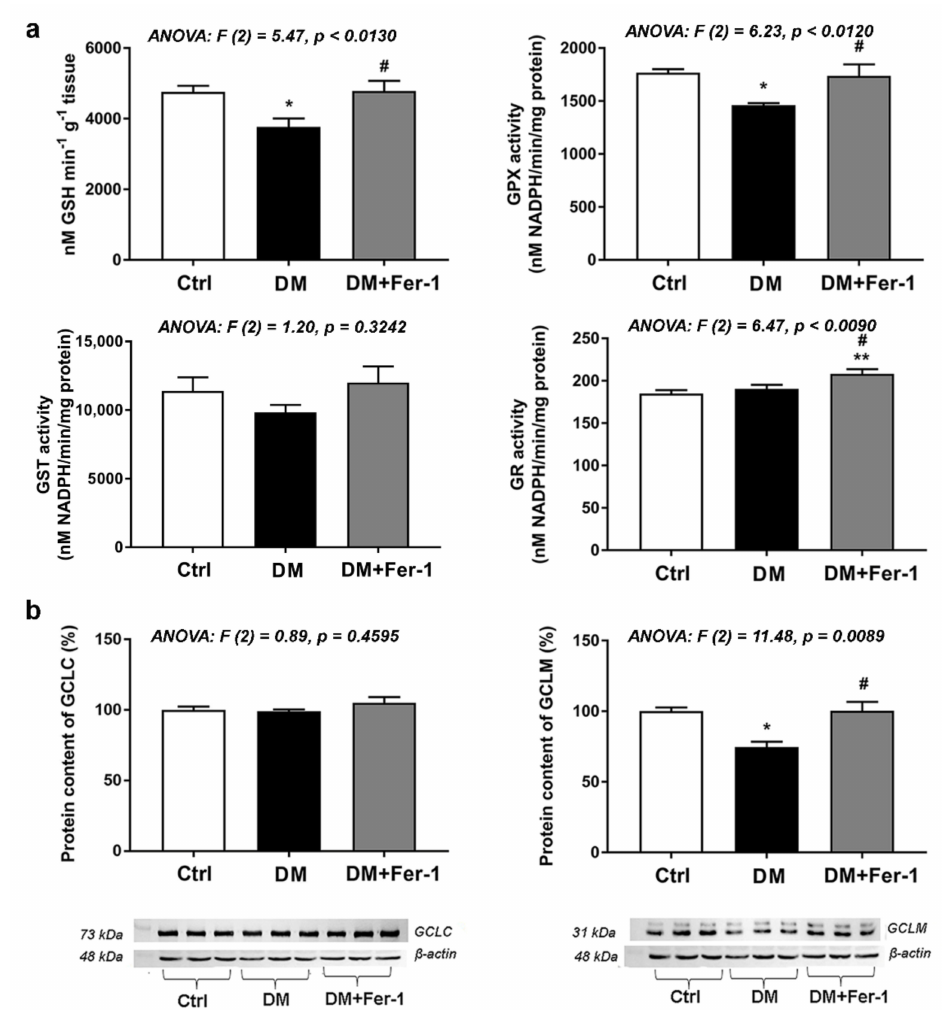
Figure 3. GSH and GSH-related enzymes in the liver of control (Ctrl), diabetic (DM), and diabetic Fer- 1-treated (DM + Fer-1) animals. ( a ) Content of GSH and activities of GPX, GST, and GR. ( b ) Protein content of GCLC and GCLM; β -actin serves as a protein-loading control; blots represent three independent experiments. Values presented as means ± SEM. Statistical significance: compared with the Ctrl group (*), * p < 0.05, ** p < 0.01; DM vs. DM + Fer-1 comparison (#), # p <